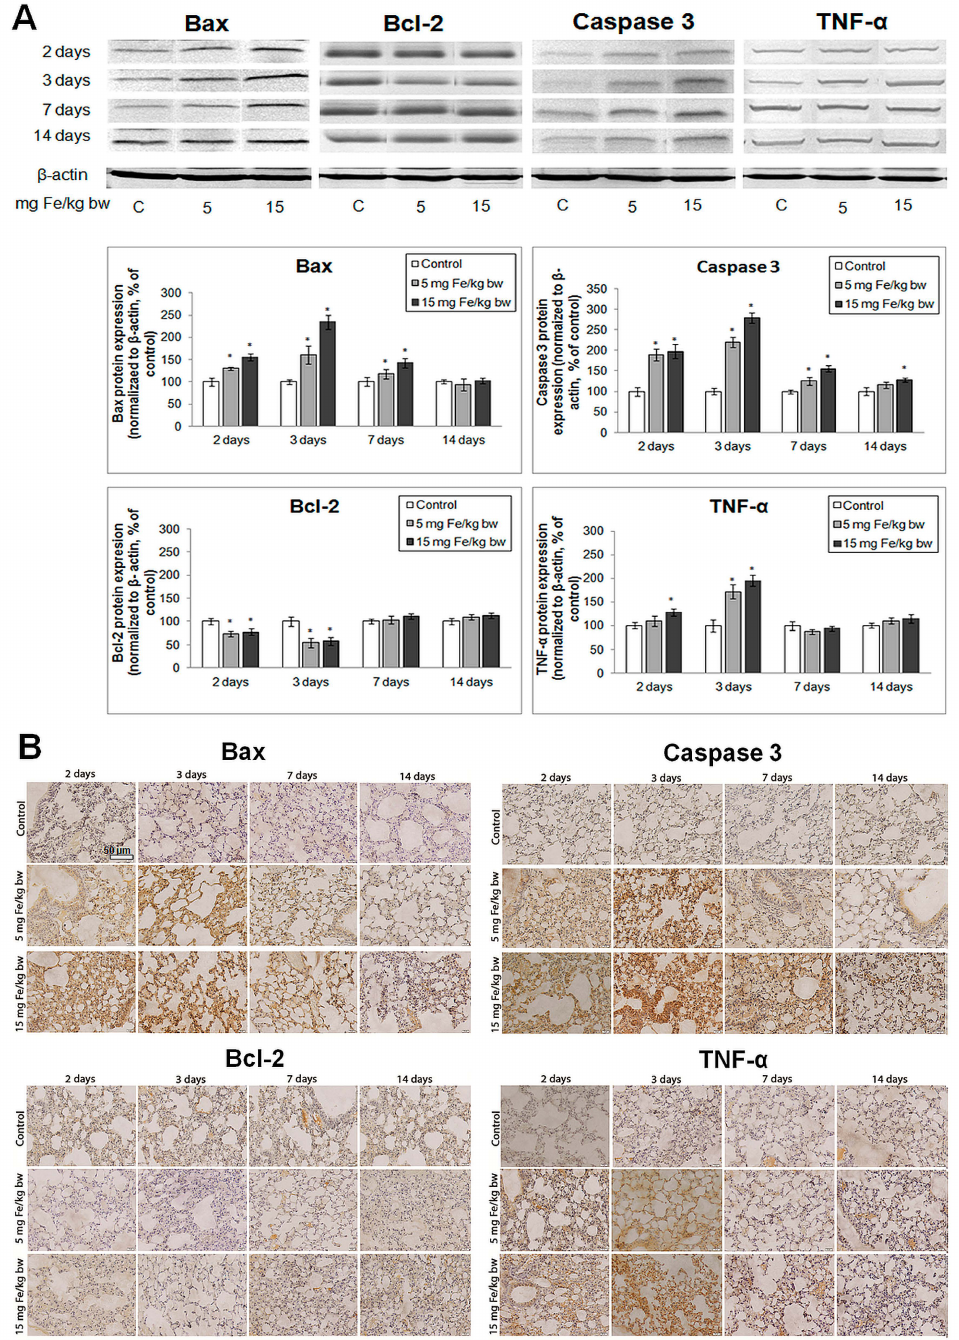
Figure 8. Expression of Bax, Bcl-2, Caspase-3 and TNF- α in the mouse lung tissue after IONPs-PM administration. ( A ) Western blot analysis (blot images and bands quantification) and ( B ) immunohistochemistry (IHC). Scale bar is 50 µ m and is the same for all IHC images. Notes: For IHC and Western blot a representative image was chosen. The values obtained from bands quantification were calculated as relative mean ˘ standard deviation of four animals per group. The difference between the treated group and the control group was significant when * p < 0.05, α (significance level) = 0.05. Data were normalized to β -actin and represented as % of control.